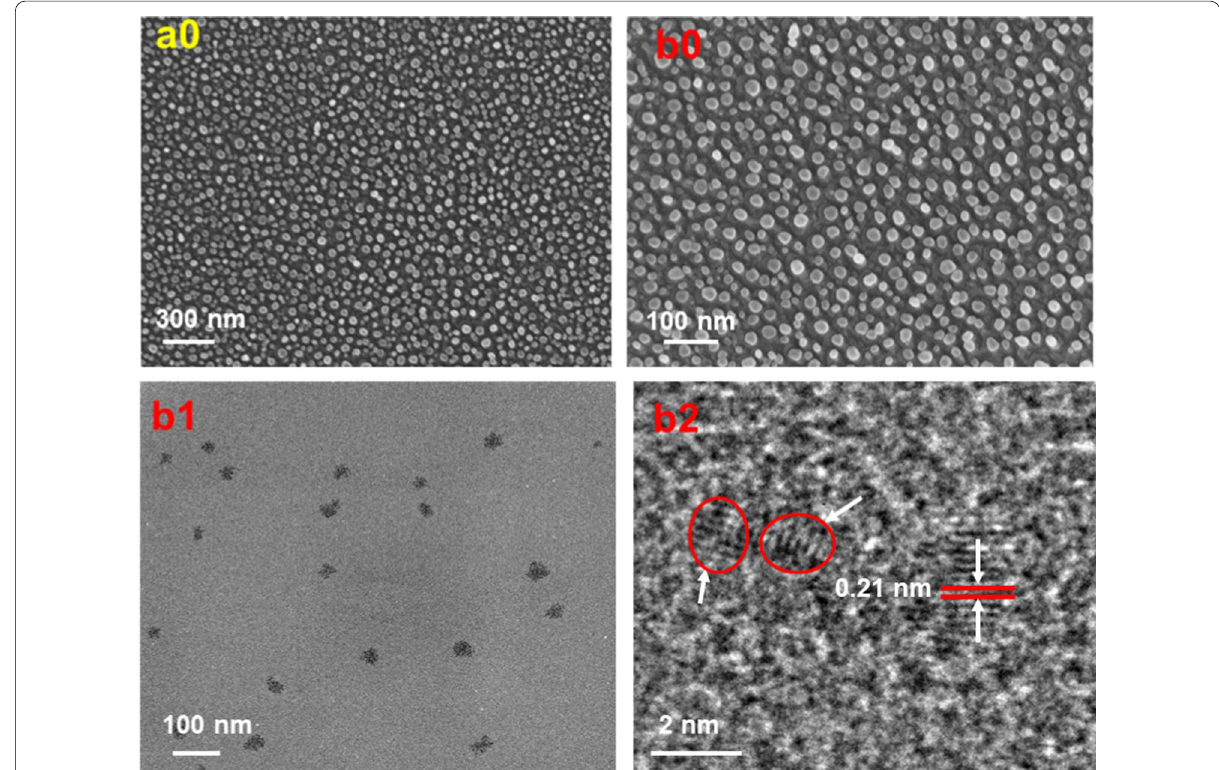
Fig. 2 SEM for CDFs with relatively lower ( a0 ) and higher magnification ( b0 ); TEM ( b1 ) HR-TEM ( b2 ) of CDFs